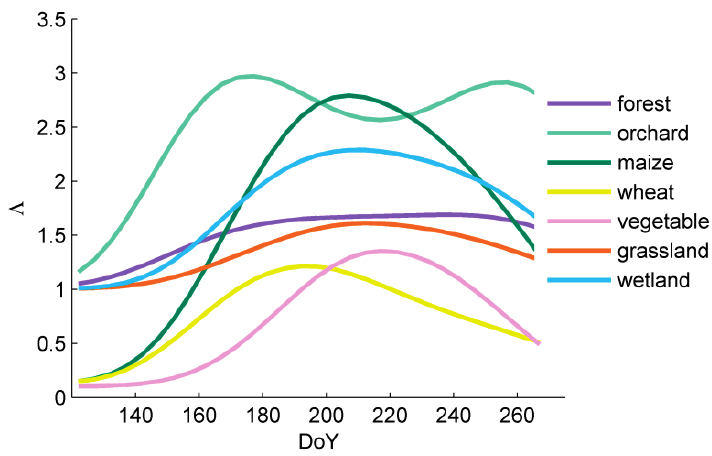
Figure 3. Time series of the area-averaged canopy area index Λ (t) of different vegetation types during the growing season of 2012 in the middle reach of the Heihe River Basin.